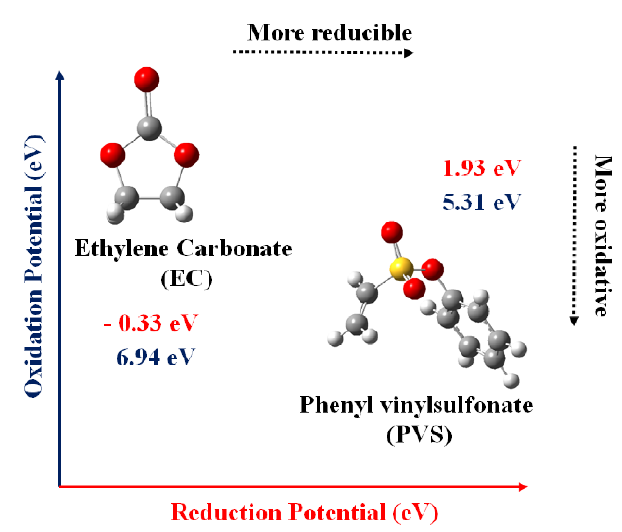
Figure 1. The oxidation and reduction potentials of EC and PVS .